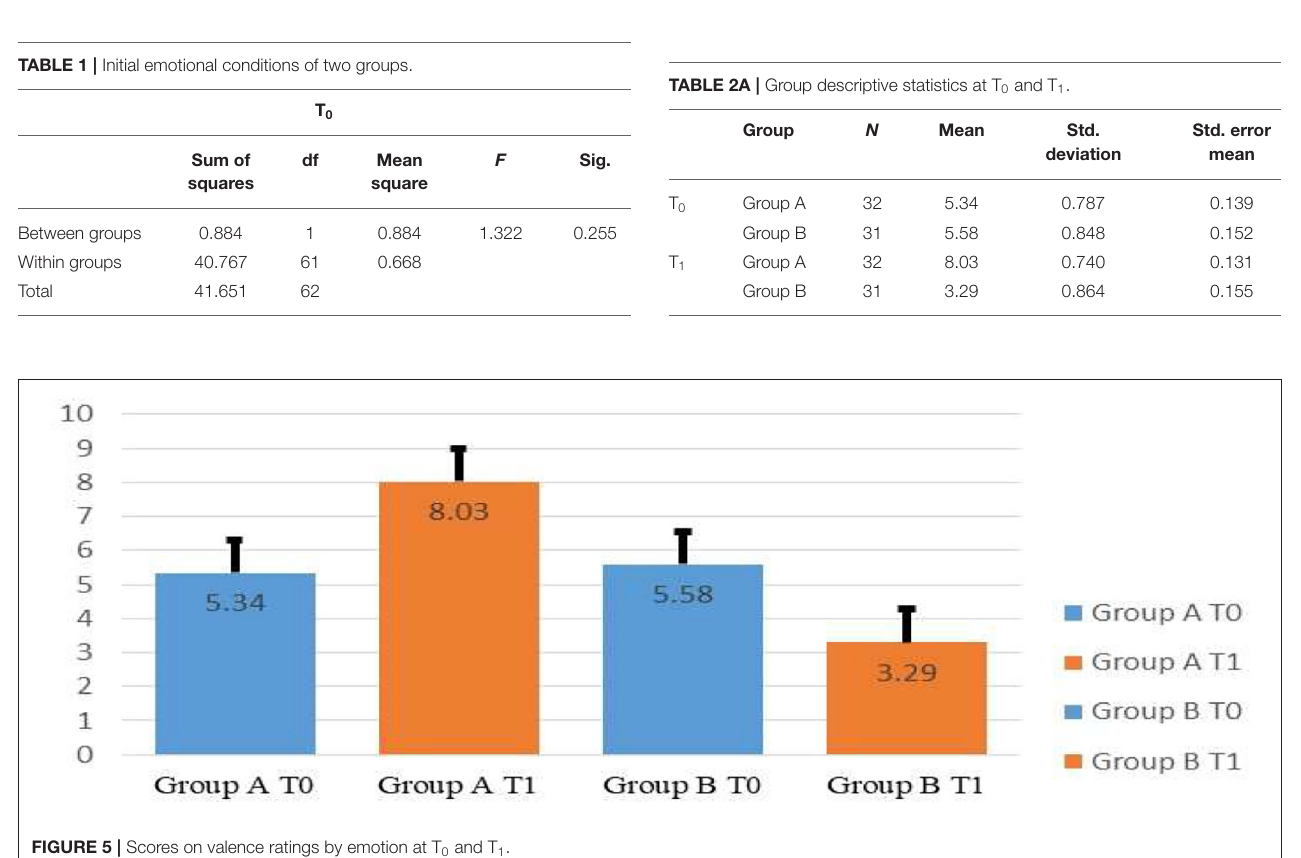
FIGURE 5 | Scores on valence ratings by emotion at T 0 and T 1